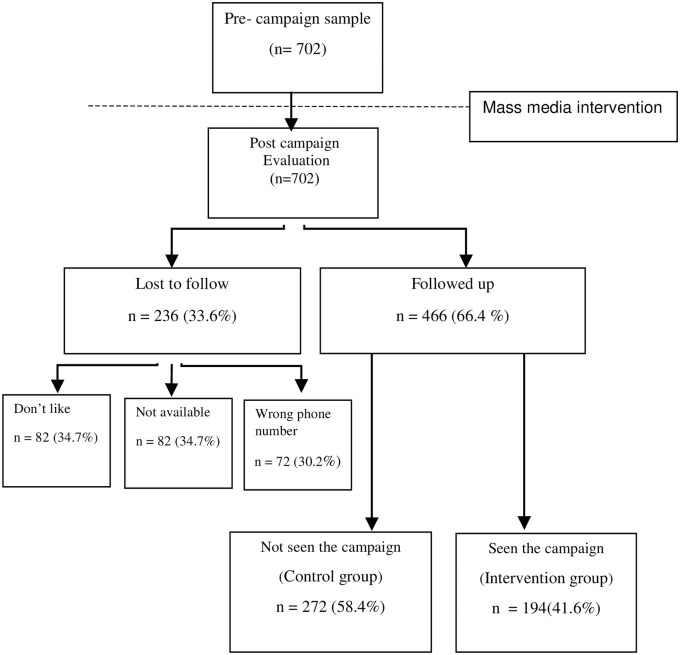
The study flowchart.